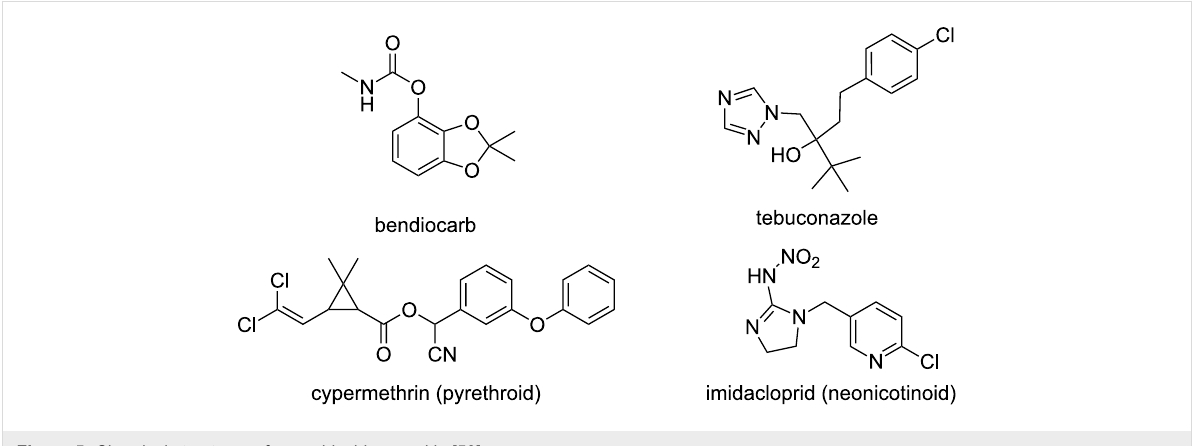
Figure 5: Chemical structures of some biocides used in [59].